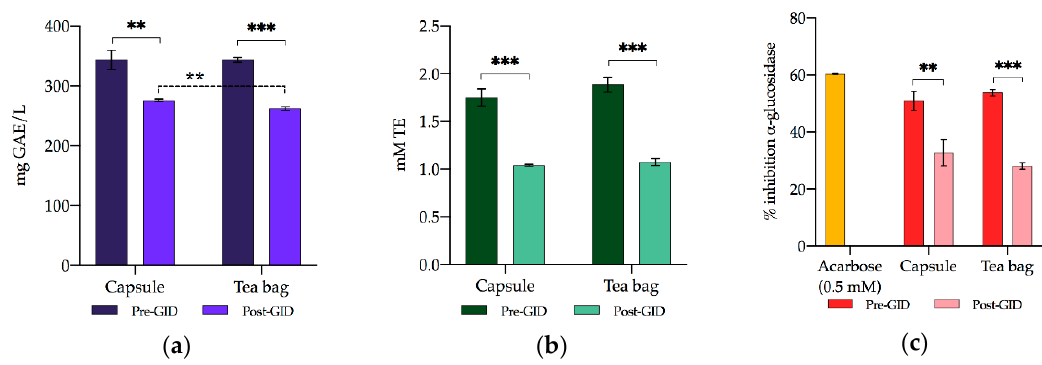
Figure 1. ( a ) TPC (mg GAE / L); ( b ) RSA (mM TE); ( c ) antidiabetic capacity (% α -glucosidase inhibition). For each panel results are reported before (Pre-Gastrointestinal Digestion (GID)) and after (Post-GID) GID for both capsule and tea bag coconut flavored beverages (E2), as well as results of ANOVA. Significance: ** = p < 0.01; *** = p < 0.001.